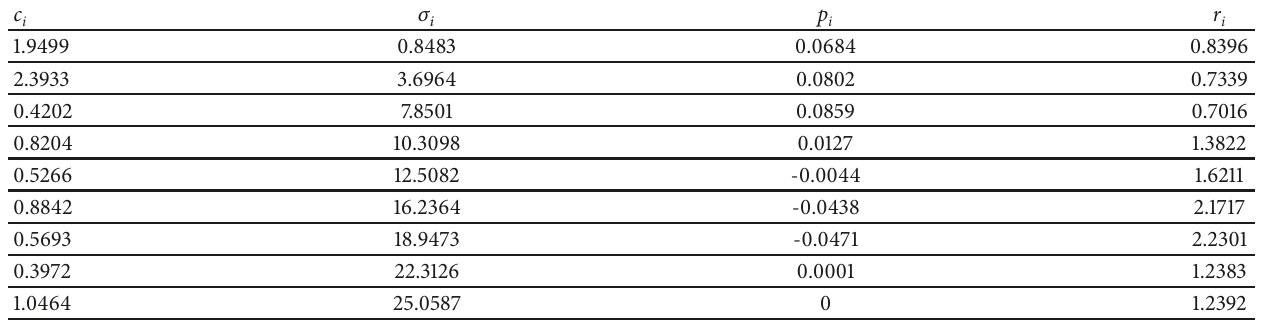
Table 4: Parameters of the ANFIS after training for the 3 rd joint (Case 2).